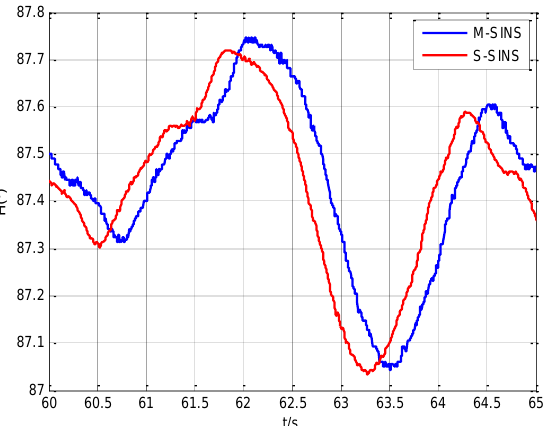
Figure 5. The heading angles’ curves of M-SINS and S-SINS.